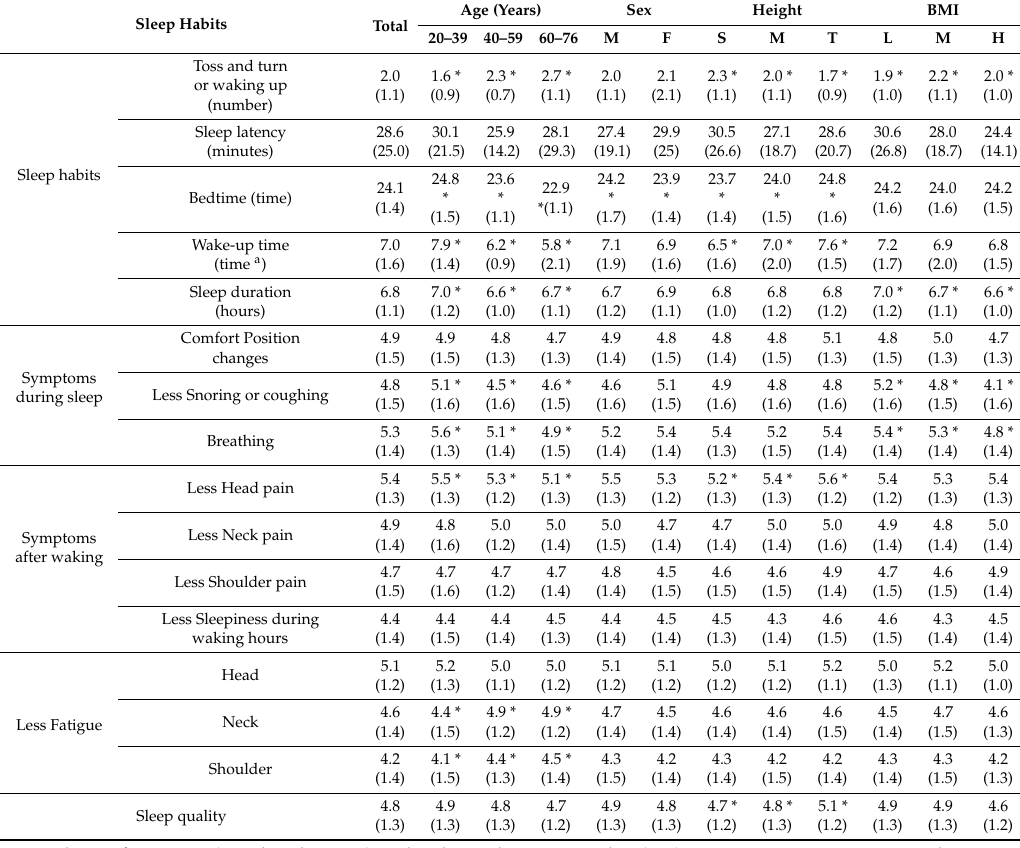
Table 3. T-test and ANOVA results for sleep habits (Mean